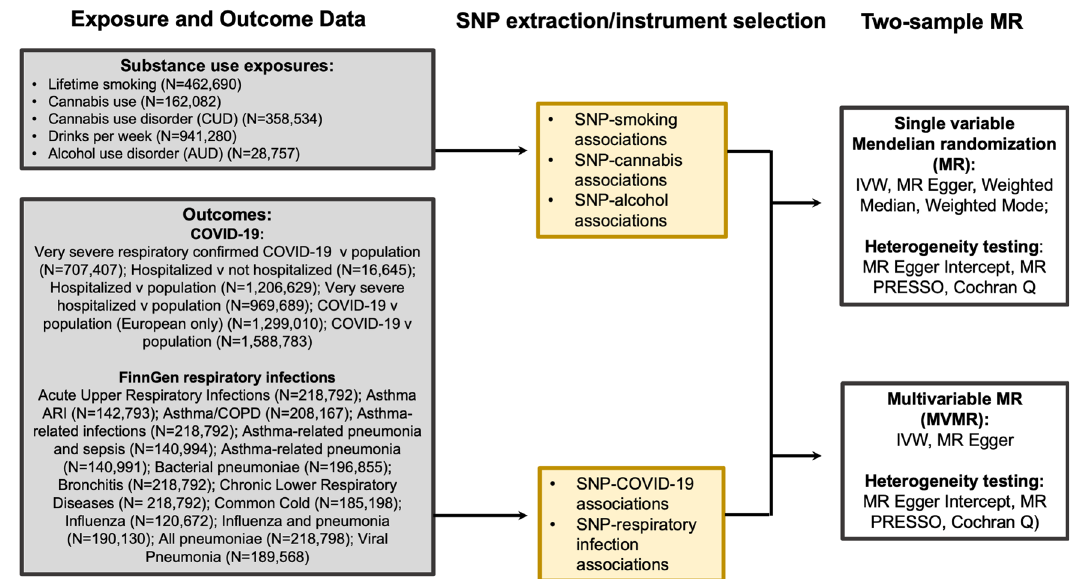
Fig. 1 Study overview. Abbreviations: SNP: single nucleotide polymorphism; COVID-19: coronavirus disease 2019; COPD: Chronic obstructive pulmonary disease; IVW, Inverse Variance Weighted MR; SVMR; single variable Mendelian randomization; GSMR: generalized summary Mendelian randomization; MVMR: multivariable Mendelian randomization; MR PRESSO: MR pleiotropy residual sum and outlier; HEIDI: heterogeneity in dependent